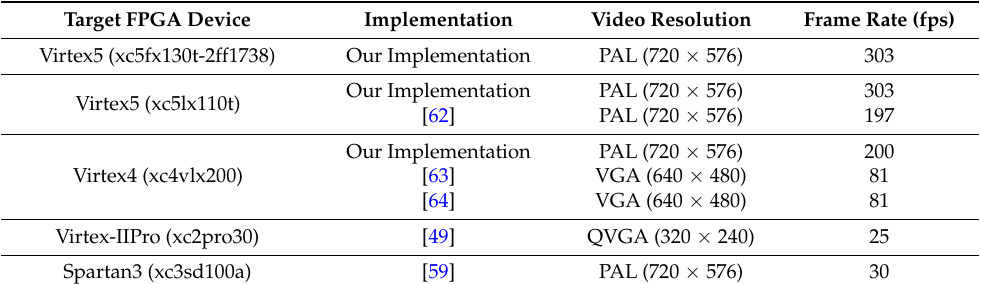
Table 3. Performance comparison with existing object tracking implementations.